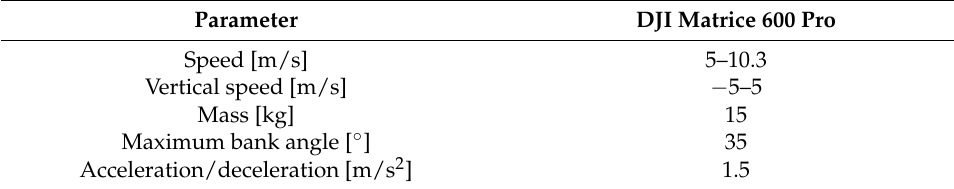
Table 2. Performance data for DJI Matrice 600 Pro used in the simulations of this